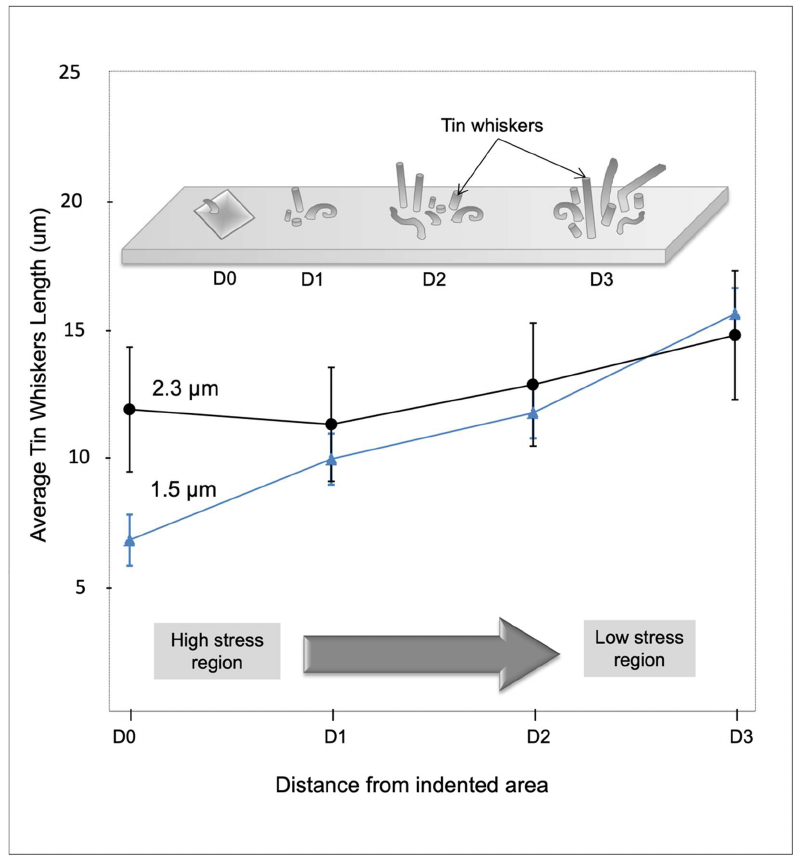
Figure 9. The average whisker length over the distance from the indentation point after 52 weeks stored under 30 °C/60% RH for 1.5 and 2.3 µm tin coatings. Inserted figure: The schematic diagram of tin whiskers formed on the immersion tin surface finish at a specific distance from the indentation point.